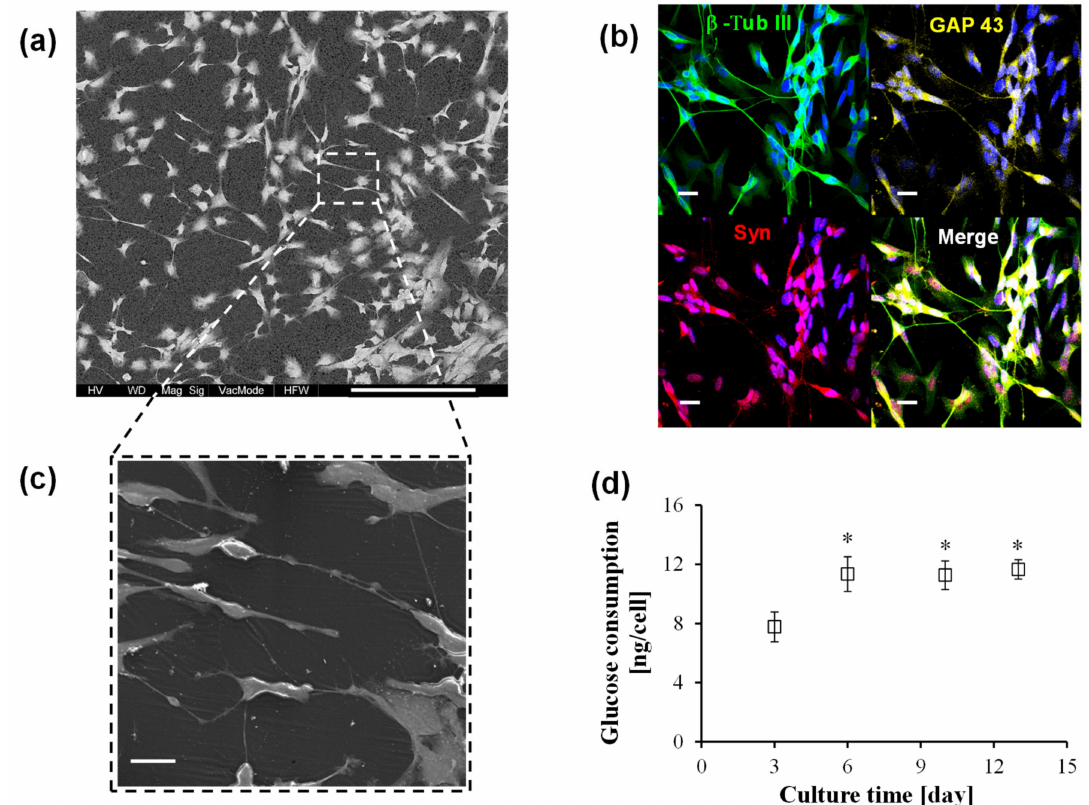
Figure 2. Neuronal differentiation in PLGA multiplex membrane platform: ( a ) and ( c ) are SEM micrographs at different magnifications (scale bar = 200 µ m and 20 µ m, respectively), and ( b ) is a confocal laser scanning microscope image of neuronal cells after 14 days of culture in the membrane system (scale bar = 20 µ m); cells were stained for neuronal markers β III-tubulin (green), synaptophysin (red), Growth Associated Protein 43 (GAP-43, yellow) and cell nuclei marker (DAPI, blue); ( d ) glucose consumption of neurons were cultured within the PLGA membranes device up to 14 days; the values, expressed as average ± SD, are the means of three experiments, and statistical analysis was performed according to an ANOVA followed by a Bonferroni t -test ( p < 0.05): * vs. day